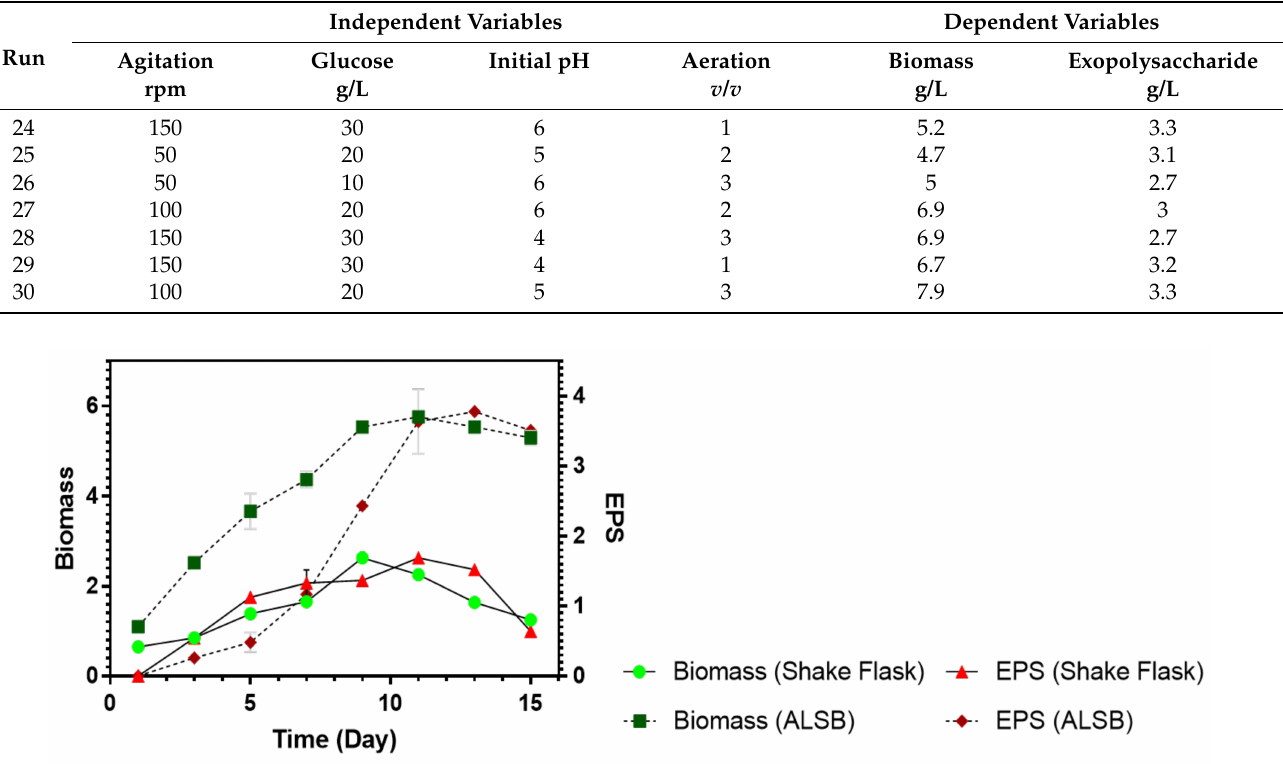
Figure 2. Growth curve of G. lucidum in shake flask compared to